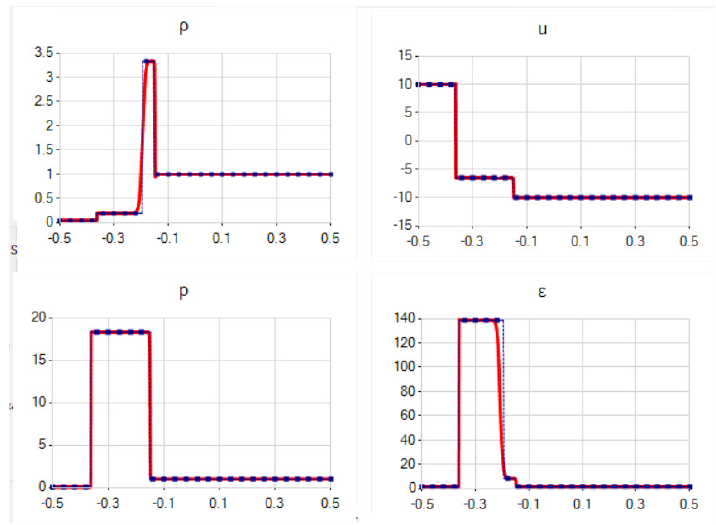
Figure 6. Test 5b. Solutions for α = 0 . 4, β = 0 . 1 and N =